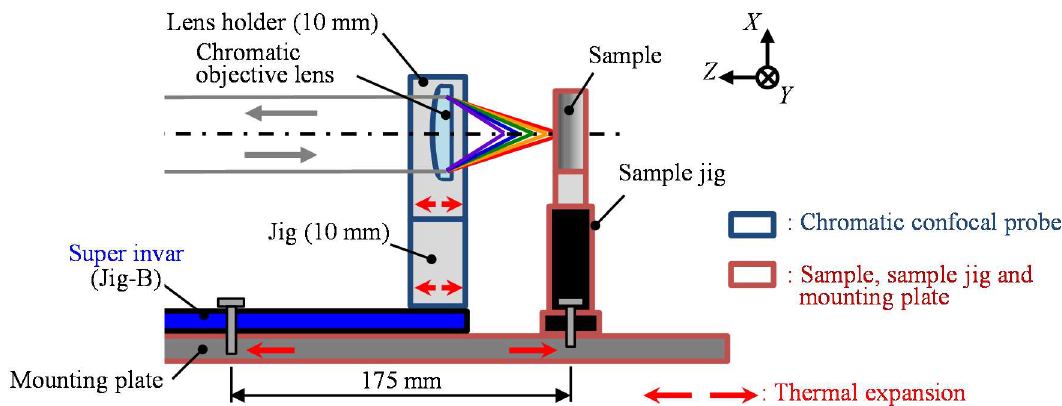
Figure 13. A schematic of the chromatic confocal lens and the target sample in the second prototype chromatic confocal measurement setup shown in Figure 11b.